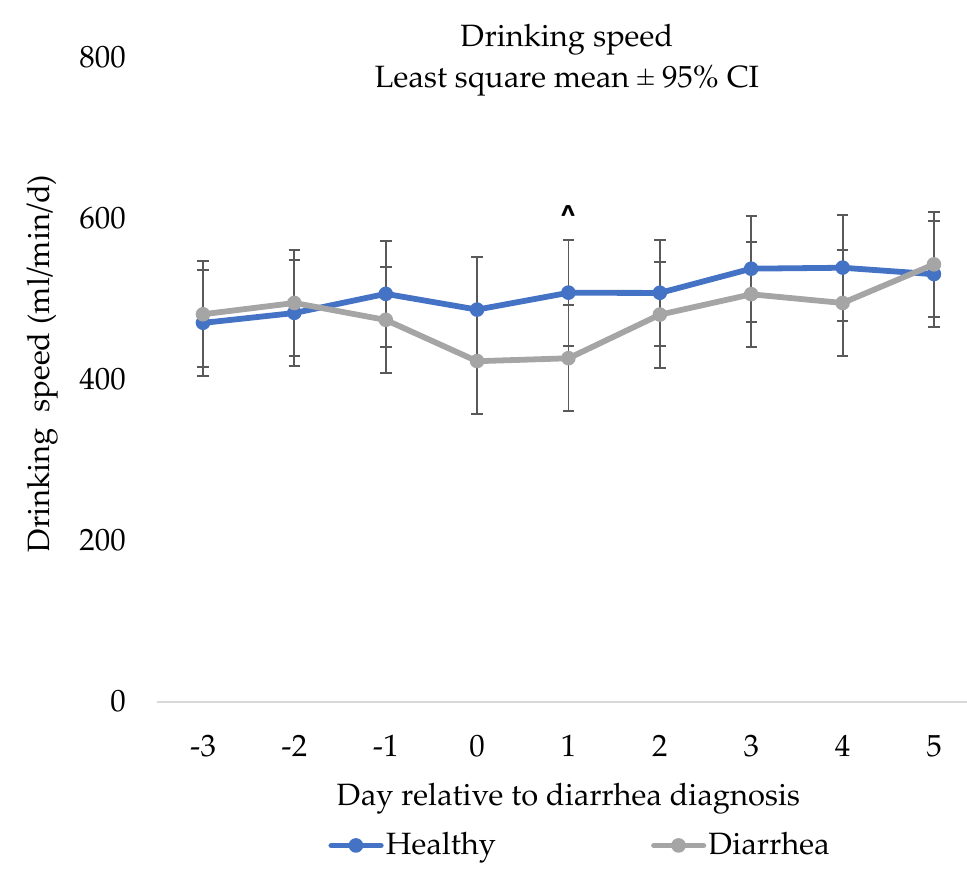
Figure 2. Results of the repeated measures mixed linear regression model assessing the relationship between day relative to neonatal calf diarrhea diagnosis (day 0) and drinking speed (mL/d) of pair matched control ( n = 31) and diarrhea ( n = 31) calves fed by an automated milk feeder, preweaning. A calf was defined as having neonatal calf diarrhea if they had a fecal consistency score of 2 or 3 (runny to watery consistency) for two or more consecutive days. Calves were matched on farm, gender and age and the model included calf and pair number to account for the matched pair analysis. The error bars represent ± 95% confidence interval. ˆ Indicates a tendency for a difference (> 0.05 p < 0.10).